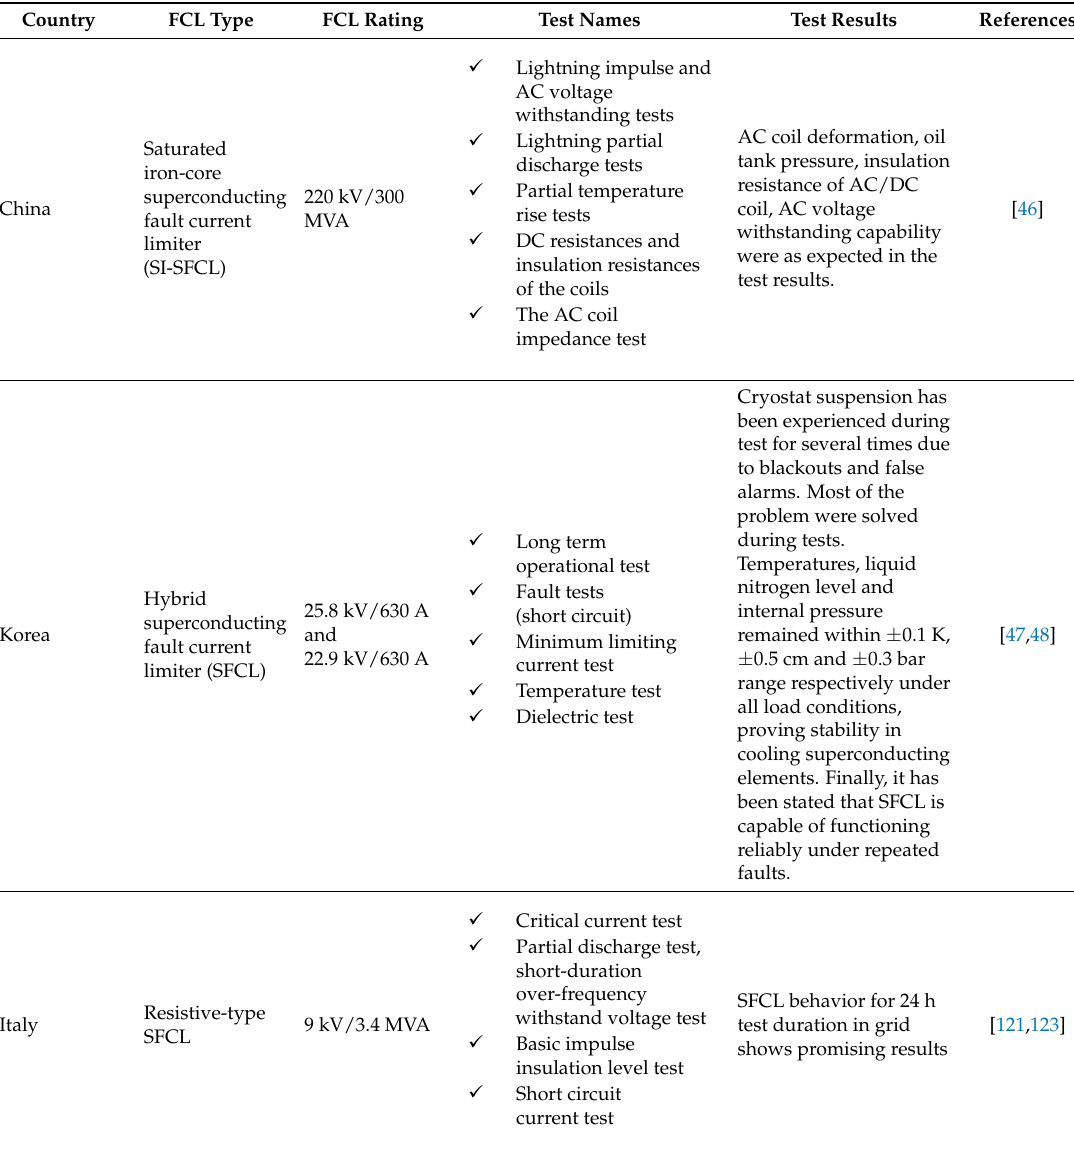
Table 5. Optimization techniques for the placement of superconducting